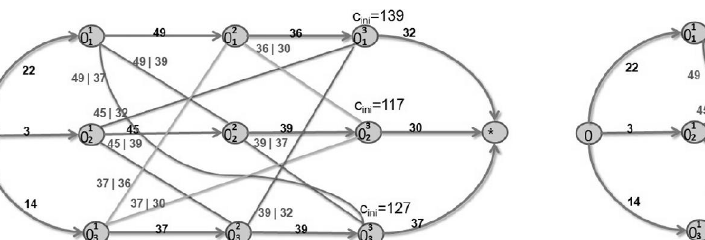
 constructed by r DR-algorithm at the first stage